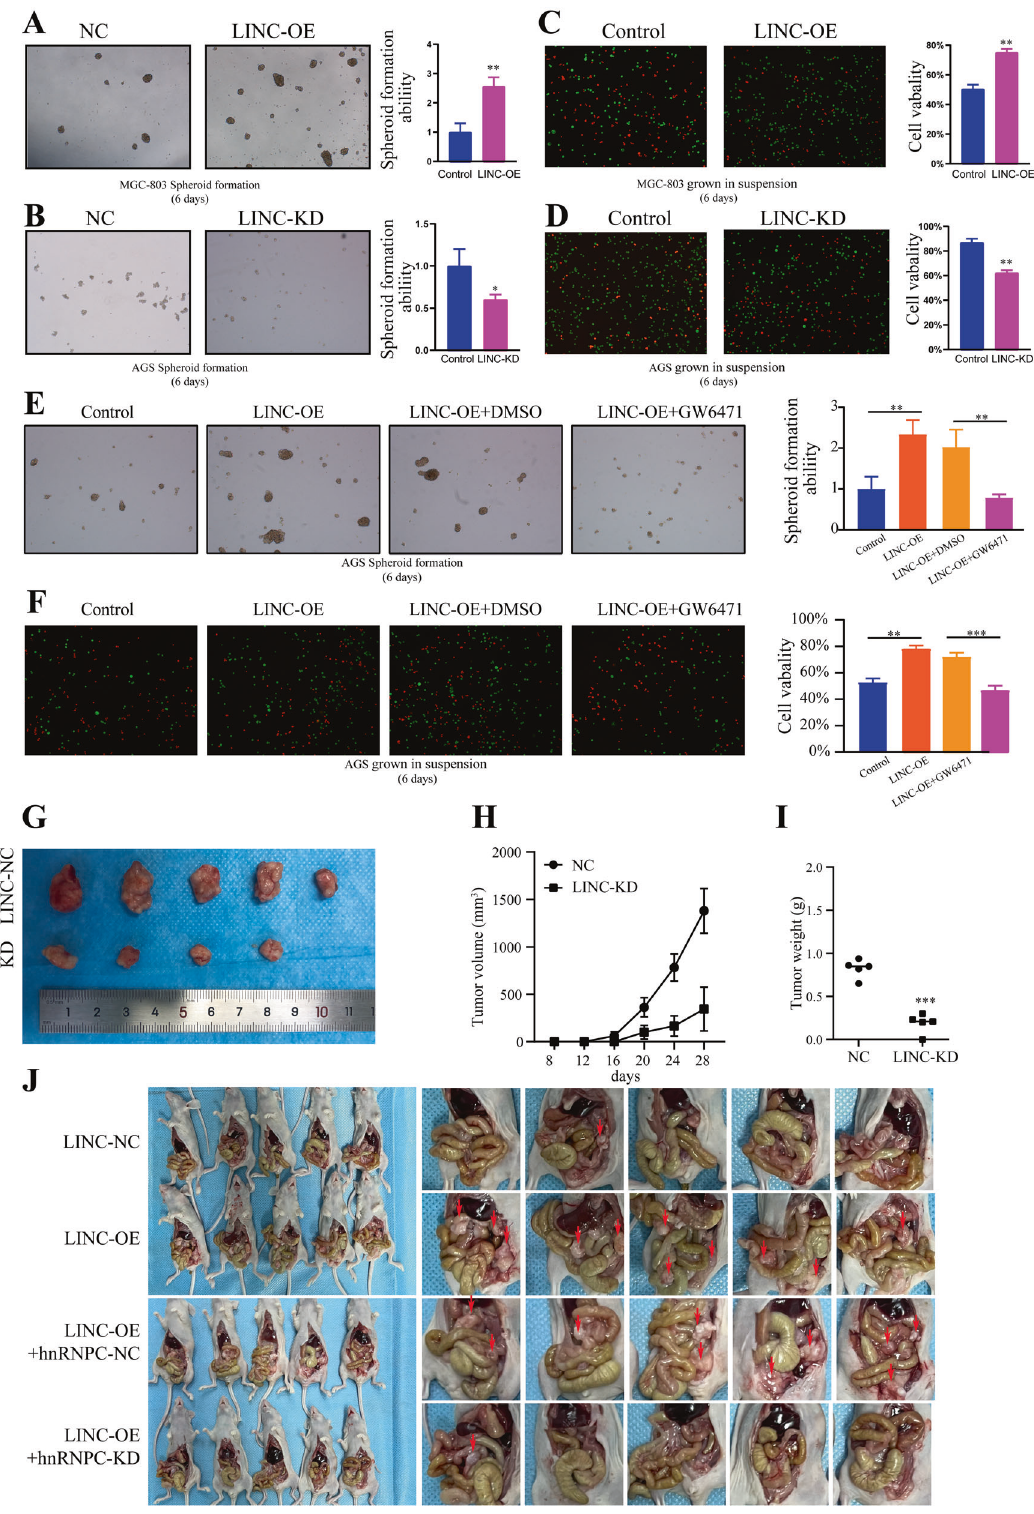
AGS cells and LINC-KD AGS cells were injected subcutaneously into nude mice. The results revealed that knockdown of LINC00924 markedly prevented subcutaneous tumor growth (Fig. 7G – I). To further prove that LINC00924 facilitates gastric cancer peritoneal metastasis via hnRNPC, we constructed stable